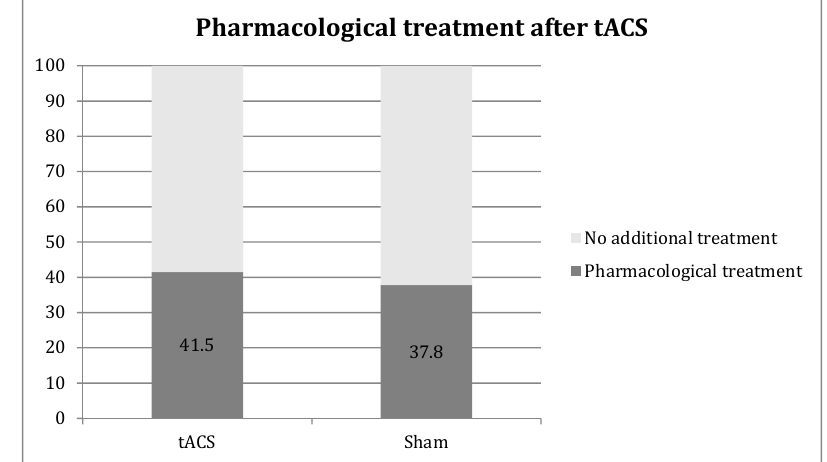
Figure 1. Medication use after transcranial alternating current stimulation (tACS) treatment. The Y axis represents 100% of the migraine